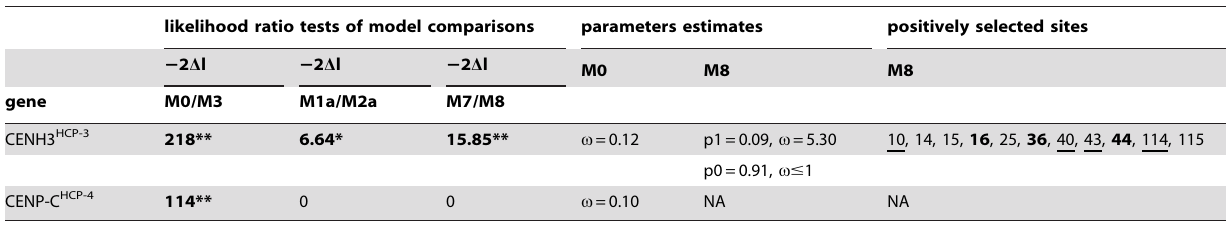
likelihood ratio tests of model comparisons parameters